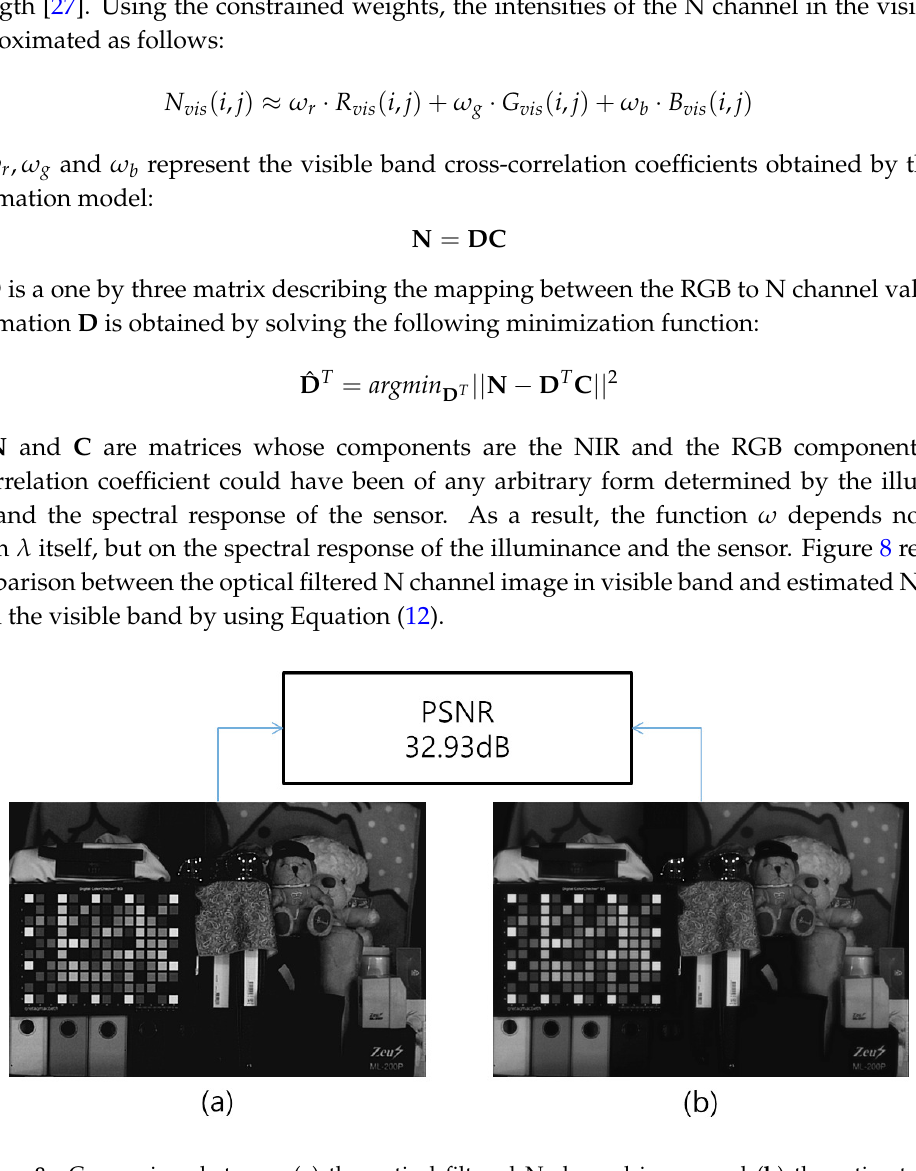
Figure 8. Comparison between ( a ) the optical filtered N channel image and ( b ) the estimated N channel image in visible